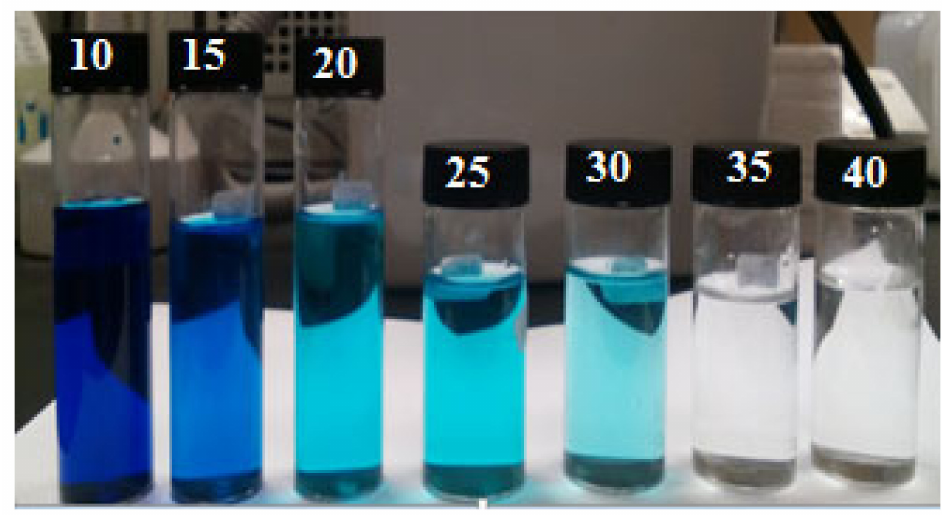
Figure 13. The images show MB solutions approaching adsorption equilibrium at 5-min intervals (10–40 min).